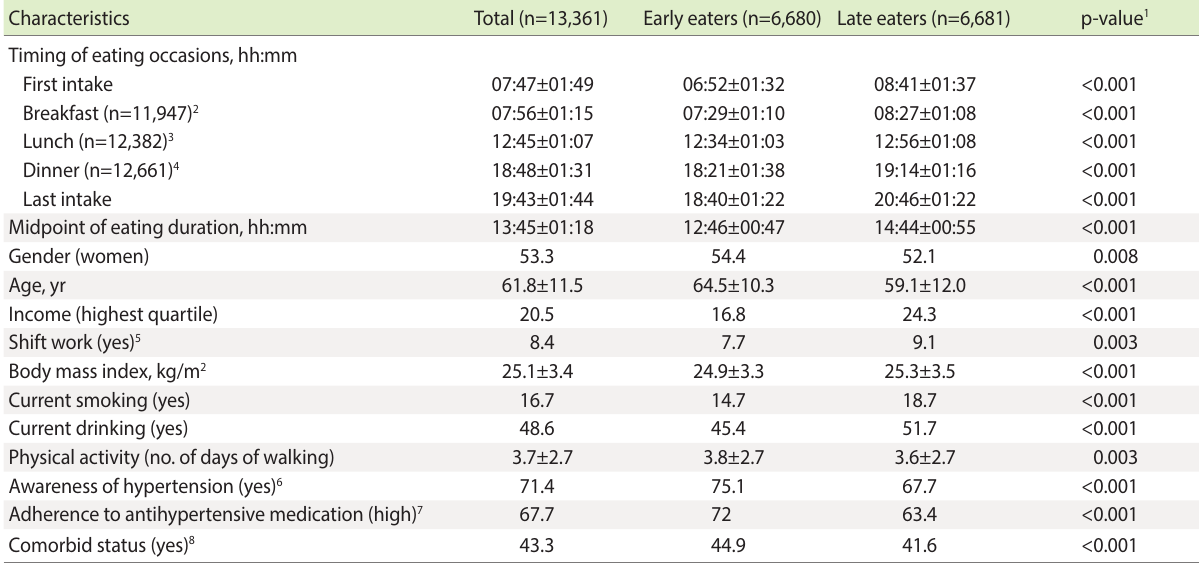
Table 1. Time of eating episodes and general characteristics according to late eating in adults with hypertension